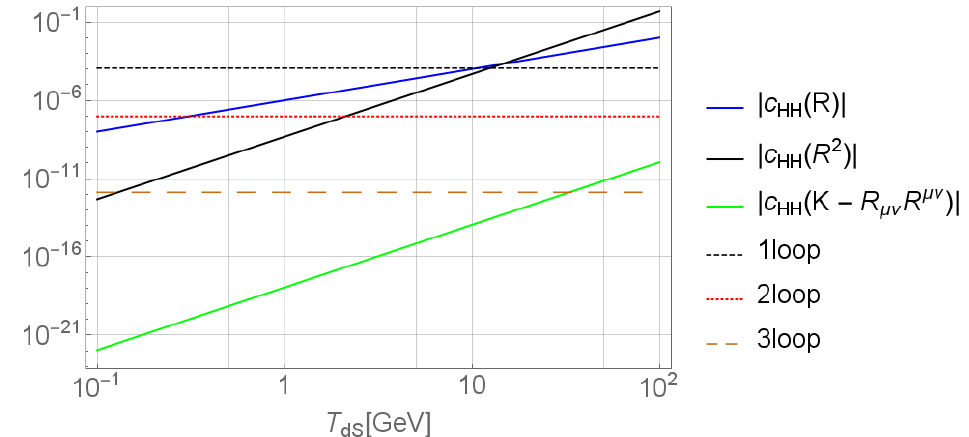
Figure 3 . The contribution of the gravity induced part of the c HH coe(cid:14)cient to the Higgs quartic coupling in the de Sitter like FLRW background. The c HH is given by (3.23). Loops prefactors are n +1 given by the formula nloop= (cid:21) and T dS is the temperature of the de Sitter spacetime. For H (16 (cid:25) 2 ) n the plot we chose (cid:21) HX = 0 : 25, (cid:21) H = 0 : 13, m X = 10TeV and (cid:24) X = 0. The plot was made in the double logarithmic scale.